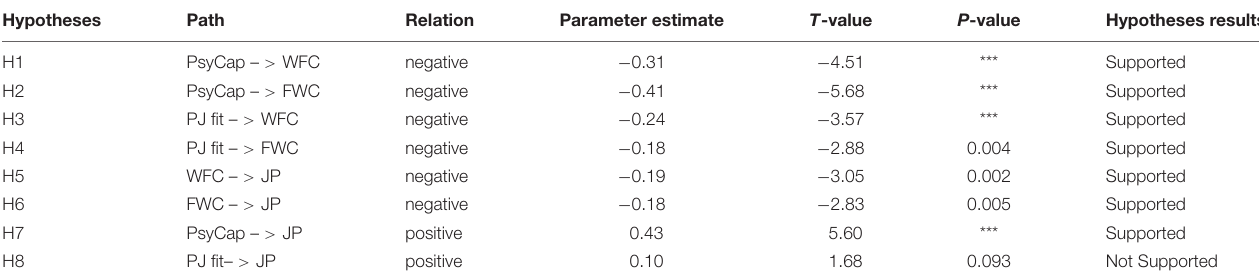
FIGURE 2 | Final structural model. TABLE 4 | Results of the hypothesis